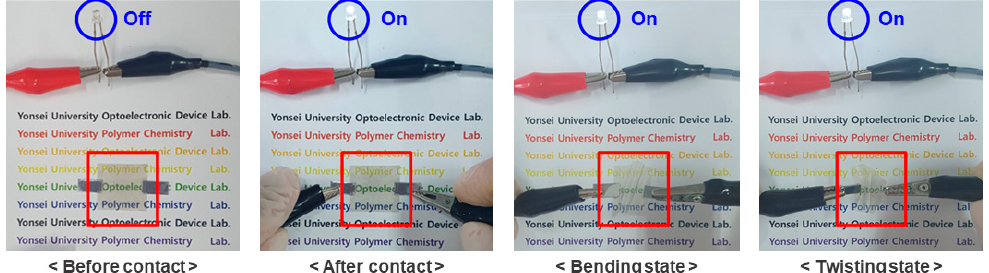
Figure 5. Demonstration of the mechanical robustness of the GCA/AgNW/GCA/cPAI-embedded electrode.